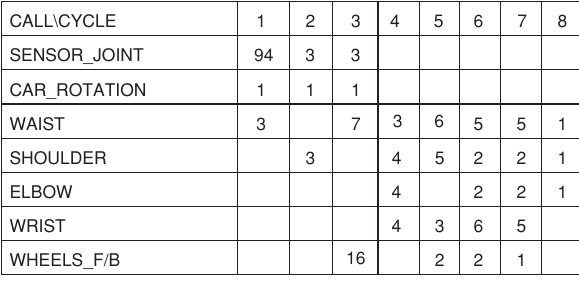
Figure 6 RN2-ROB with the orienting-reaction module. The files of the table are the calling order of the endless program and the columns, the program cycle turn. The numbers in the body of the table are the number of times of successive participations of the corresponding module in its turn. SENSOR JOINT and CAR ROTATION are the two modules that produce the orienting-reaction and the rest of the modules are responsible of a reaching behaviour. WHEELS F/B stands for the module producing the straight-line rolling movement of the car. Notice that in each cycle some modules did not contribute to the robot’s movement. This qualifies the module’s participation as